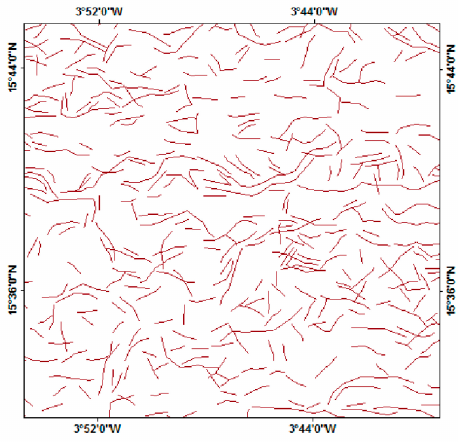
Figure 6. Map of the linear structures of the inner delta of the Niger.